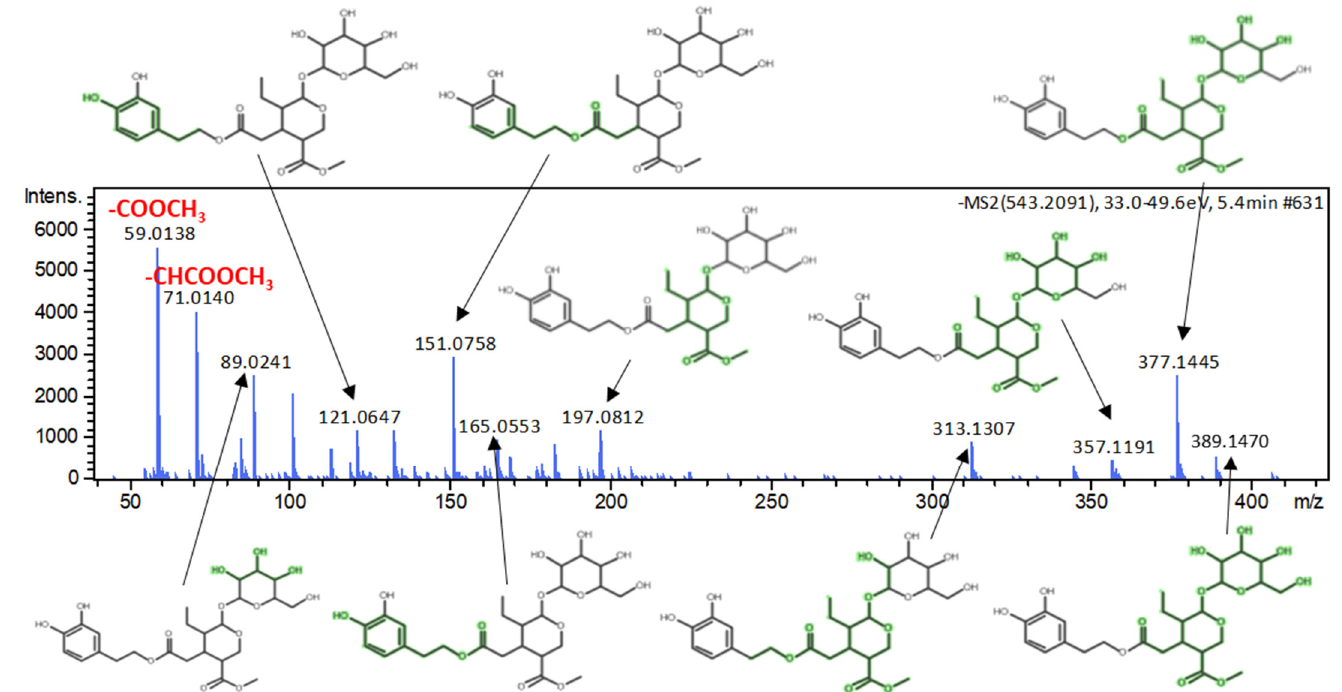
Figure 7. The structural elucidation of MS/MS fragments of dihydrooleuropein.